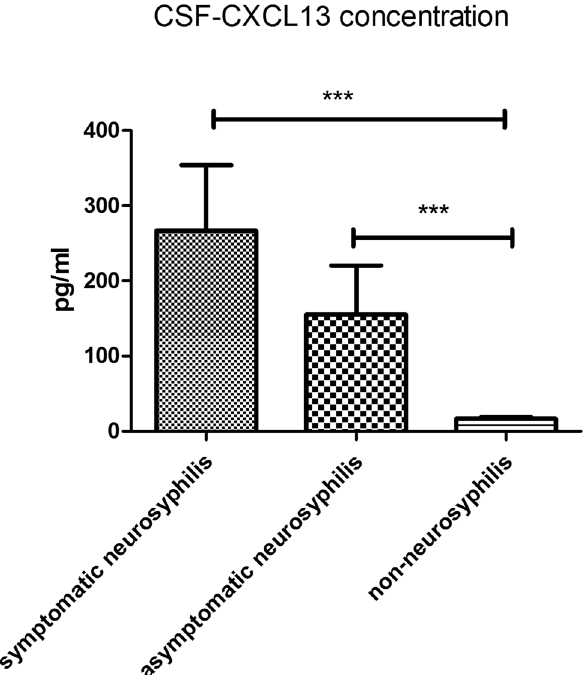
Figure 5: CXCL13 concentration in CSF among three groups. *** p <